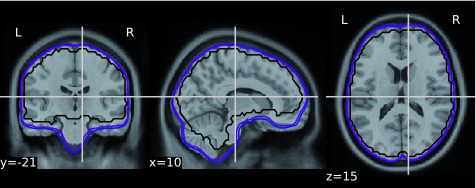
Overlap of the EPI derived 1,969 brain masks in the MNI space: voxels inside the blue outlined were present within the mask for 85% of runs, purple: 95% of runs, black 100% of runs.Animated visualizations of all coregistrations are available inside the HTML reports included as part of this dataset.